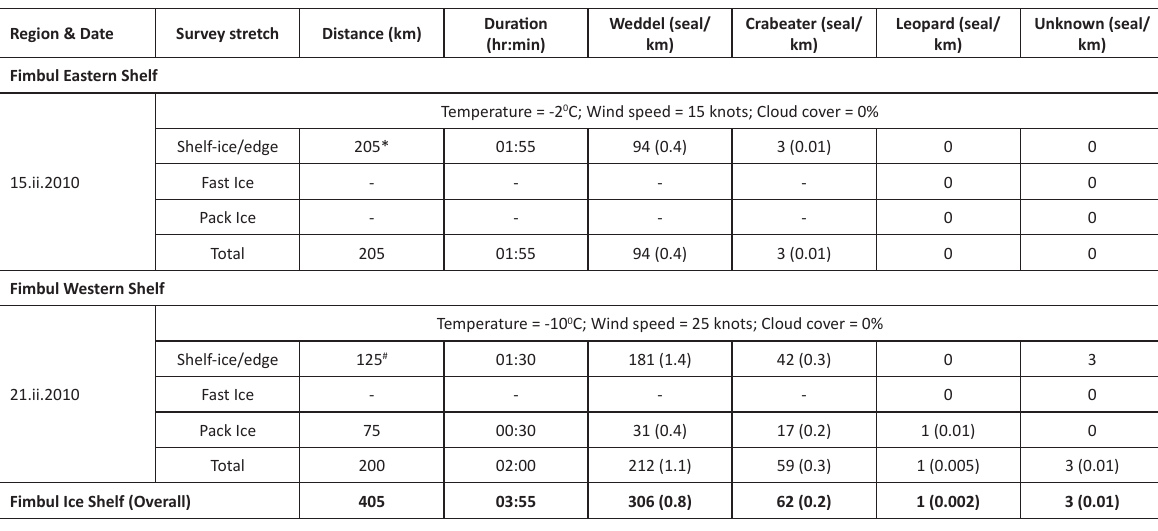
Table 1b. Details of the aerial survey for seals carried out in the Fimbul Ice Shelf site during February